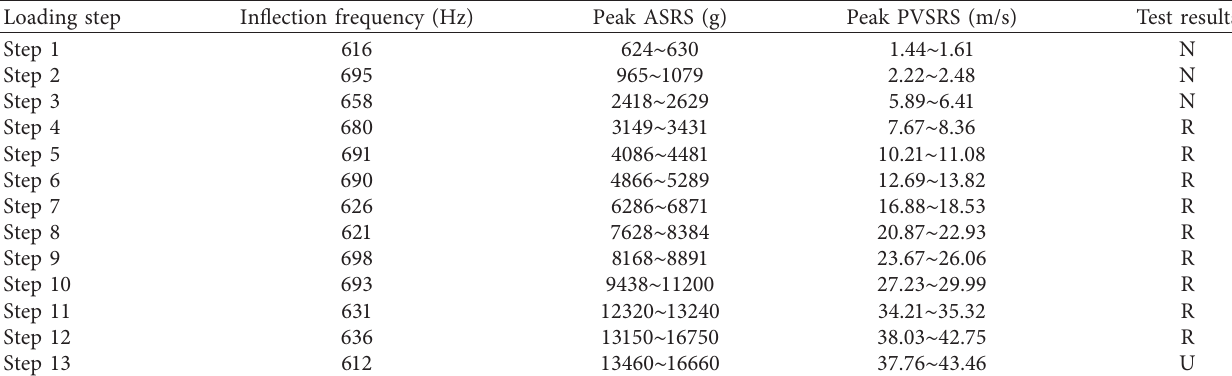
Figure 11: The error caused by the deviation in the measurement Table 5: Performance of crystal oscillators on the C1 board.